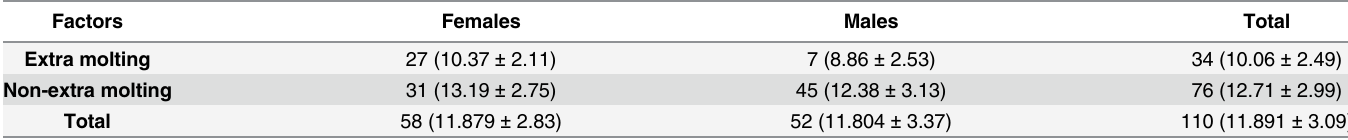
Table 1. Distribution of the 110 surviving individuals by sex and by development strategy. Average hatch weight (in mg) for each class are indicated between brackets (mean ± sd).